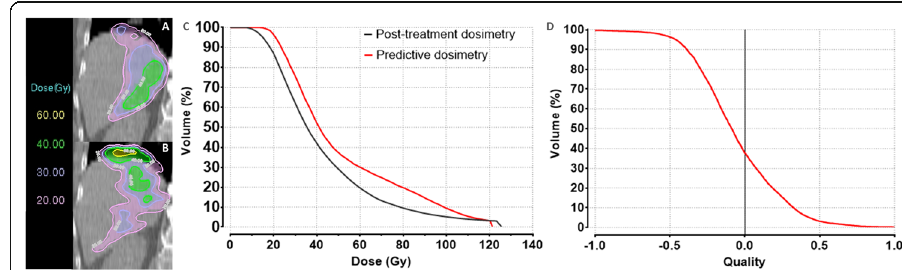
Fig. 3 Example of discordance between DVHs and QVH analyses. a Coronal D Post-treatment-R image, showing doses ranging from 20 to 40 Gy in the NTL. b Coronal D Predicitve-D image, showing doses ranging from 20 to 60 Gy in the NTL. Areas covered by the different isodoses are similar, but their patterns are different. c DVHs obtained for patient ’ s NTL at predictive and post-treatment dosimetry, showing the similarity between the two dosimetries. d Corresponding QVH showing a poor agreement (QF = 0.34) between the two